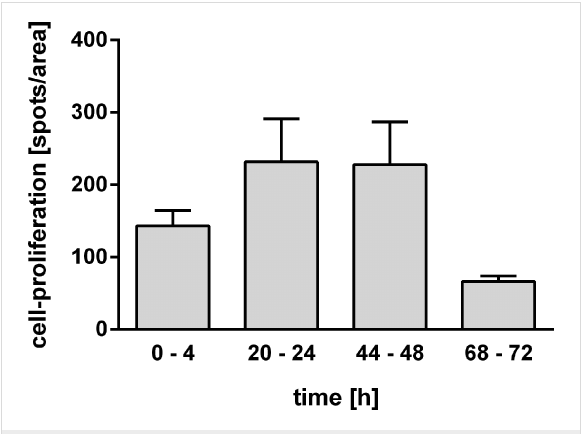
Figure 3: Cell proliferation in PCLS as determined by Click-iT ® EdU Alexa Fluor ® 488 Imaging Kit (Invitrogen) at four different time frames ( n = 4 PCLS per time point, three different areas; no significant